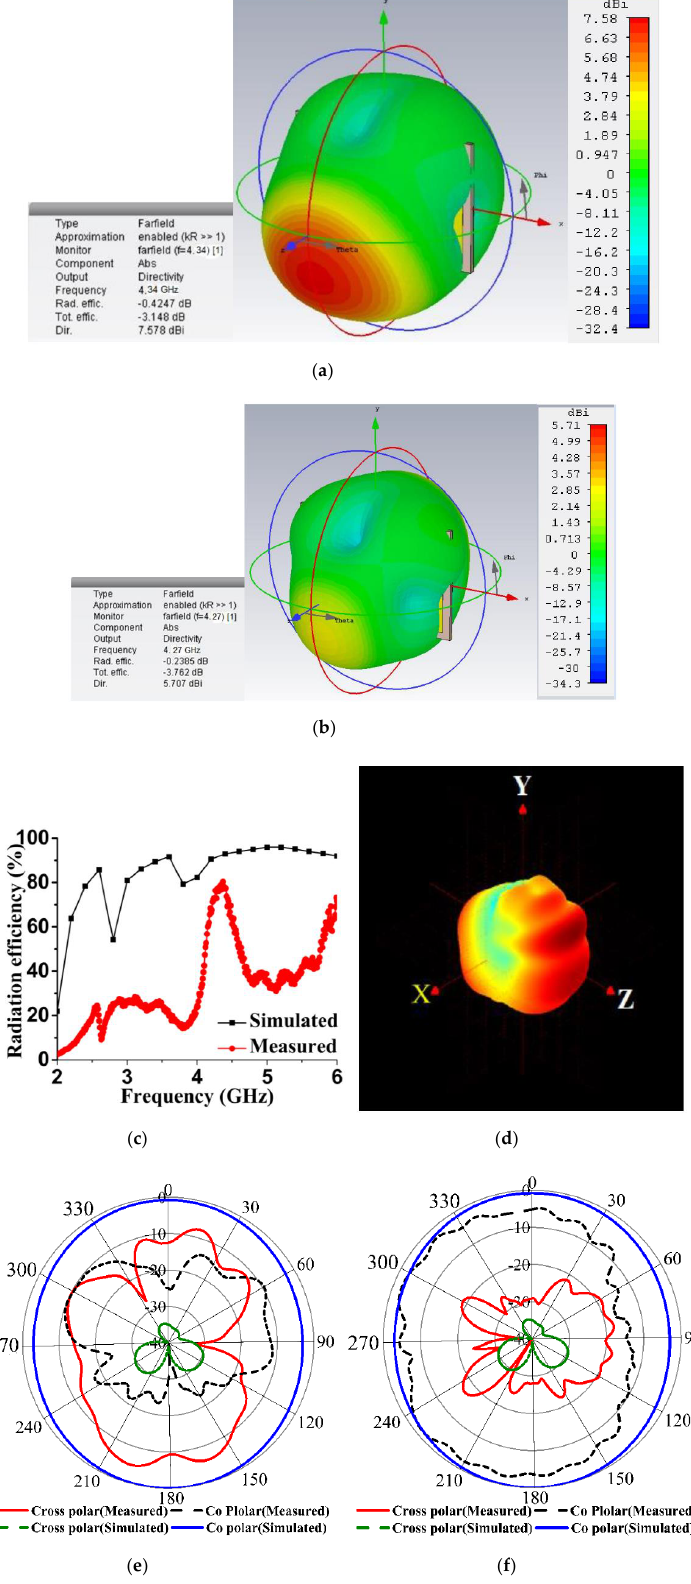
Figure 11. Radiation characteristics of the proposed antenna far-field radiation pattern ( a ) at 4.34 GHz; ( b ) 4.27 GHz; ( c ) Simulated vs. measured radiation efficiency; ( d ) Measured radiation at 4.30 GHz; ( e ) E-plane radiation; ( f ) H-plane radiation at 4.30 GHz.